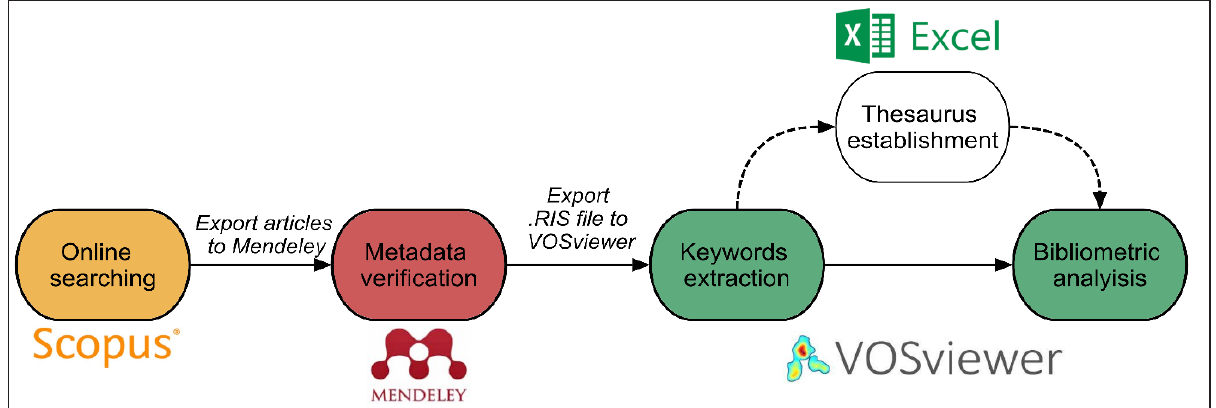
Figure 1. Activities and software used in the bibliometric